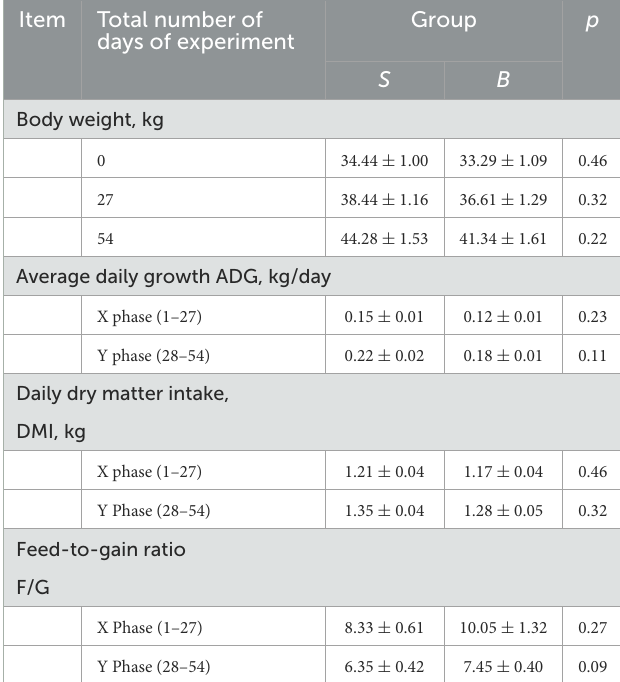
TABLE 1 Ingredients and nutrient composition of diets fed to the animals (dry matter basis).